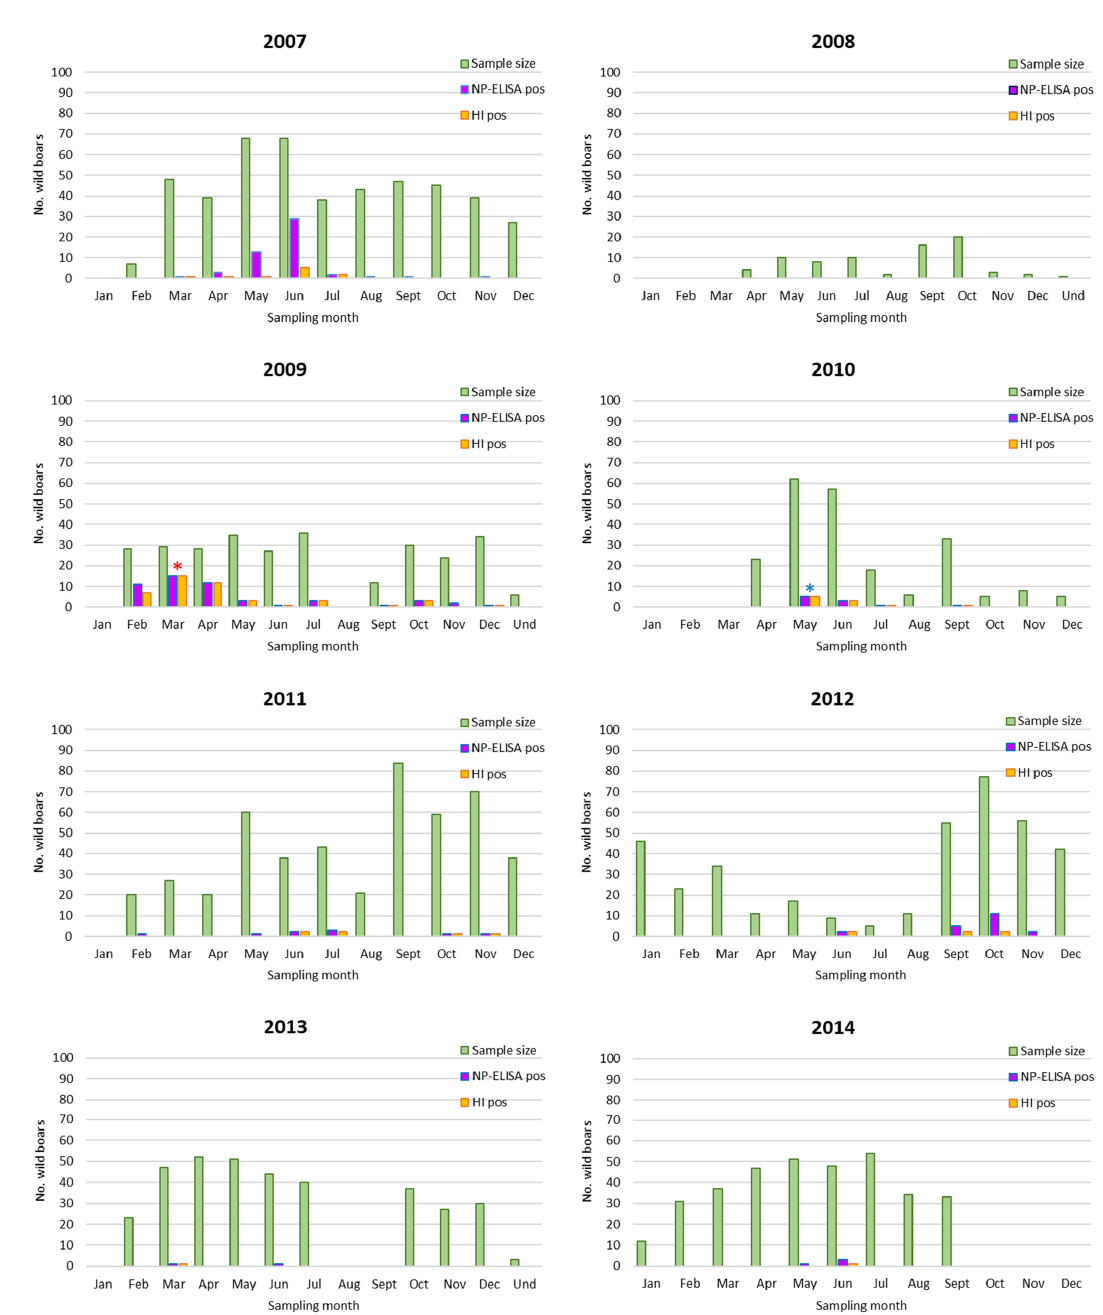
Figure A1. Serological investigations of influenza A virus (IAV) in free-living wild boar population (Northern Italy, 2007–2014). IAV seropositivity (obtained by NP-ELISA) and seroreactivity for at least one of the H1N1av, H1N1pdm, H1huN2 and H3N2 sIAV antigens used in the HI assay are categorized by year and month. * , one recaptured wild boar showing H1N1 and H3N2 seroconversion; * , two recaptured wild boars showing H1N1 seroconversion. See Table 2 for